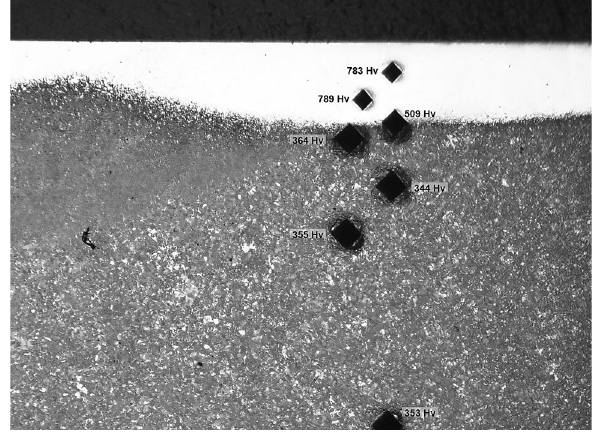
Fig. 5 Near-surface microstructure of a Class B wheel showing degradation associated with thermal loading. Martensite (bright phase), heat affected zone below martensite and pearlite